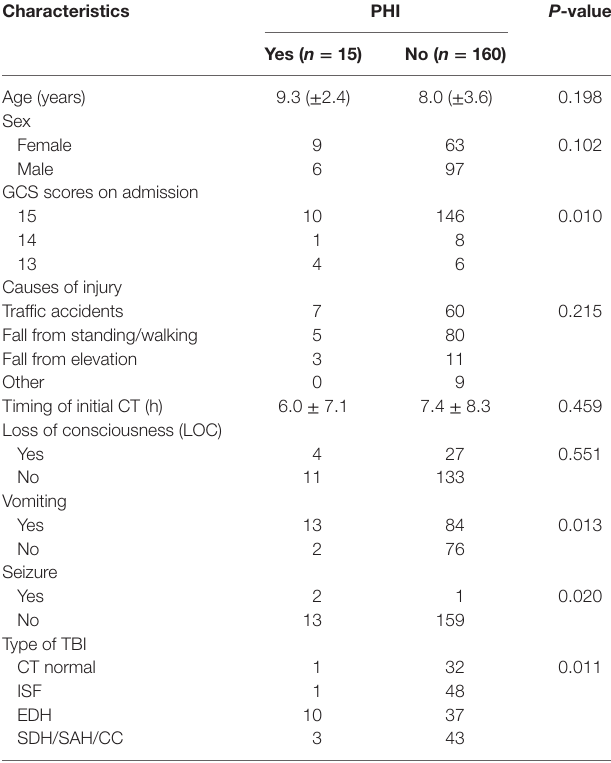
TaBle 1 | Clinical characteristics of the study